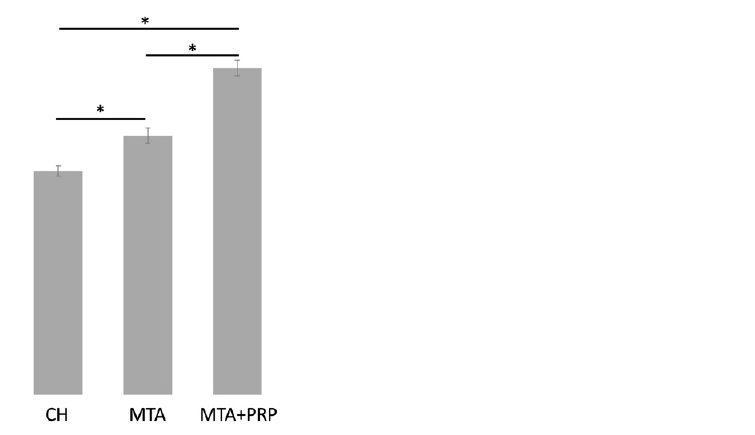
Figure 5. Relative quantitative (RQ) value of DMP1 mRNA expression at 1 h (control) and 3 days (CH, MTA, MTA + PRP) after pulp capping. In the RQ ( ∆∆ CT) condition, DMP1 mRNA was expressed in the order of CH < MTA < MTA + PRP, which was similar to the findings of DMP1 immunohistochemistry. * p < 0.05.